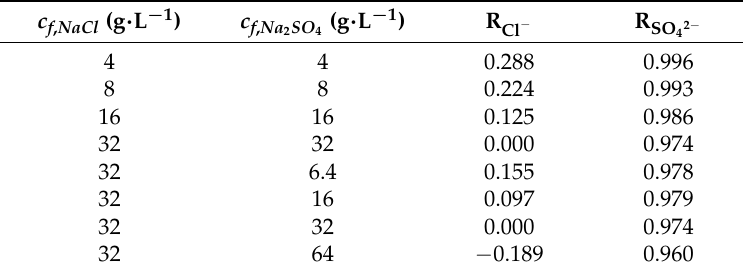
Table 1. Feed concentrations and NF